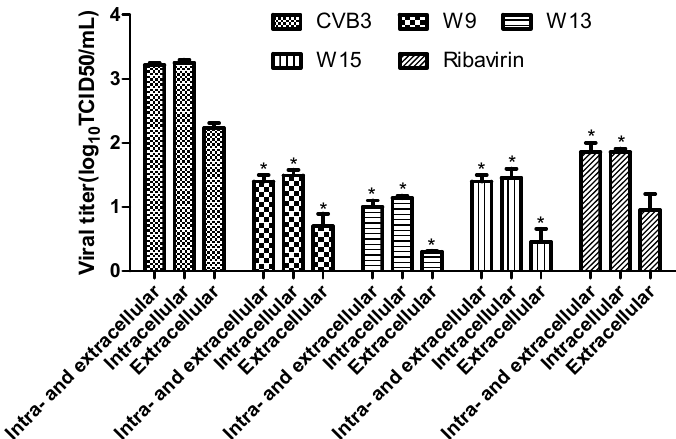
Figure 3. Analysis of the modes of action of W9, W13, and W15 against CVB3. ( a ) Analysis of effective stage. The antiviral effects of test compounds against CVB3 were detected by measuring cell viability after 48 h of infection when cells were treated with W9, W13, or W15 before, simultaneously, or after inoculation with CVB3 (100 TCID 50 ). ( b ) Analysis of the effects on CVB3 adsorption. Mock-, 120 μ M W-9-, 160 μ M W-13-, 160 μ M W-15-, or 160 μ M ribavirin-treated CVB3 (10 6 TCID 50 ) was inoculated onto Hep-2 cells and adsorbed for 2 h. Infected cells were then harvested and subjected to virus titration, using the TCID 50 method. ( c ) The effects of test compounds on CVB3 release from Hep-2 cells. Hep-2 cells infected with 100 TCID 50 of CVB3 were incubated with test compounds for 12 h, then cells and culture supernatants (intra- and extracellular) analyzed for virus yield, separately or together. Mock, no infection; VC, virus control. Values represent the means ± SDs of three independent experiments. * p < 0.05; ** p < 0.01, compared with the virus control group.